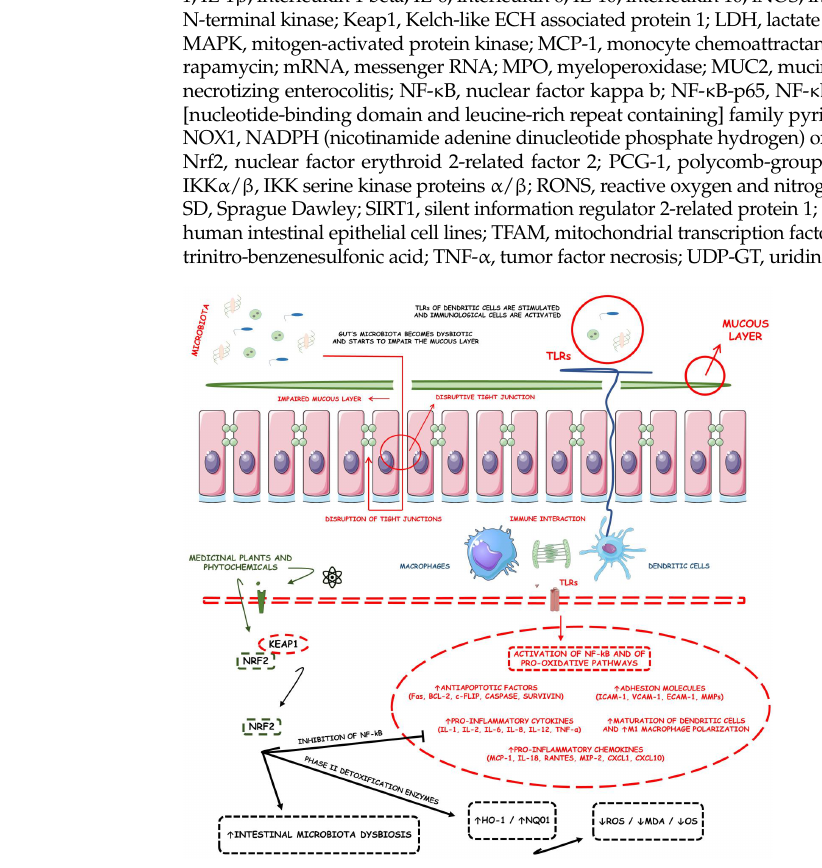
Figure 1. Inflammatory bowel diseases and regulation of Nrf2 using medicinal plants and phytochemicals. ↑ , increase; ↓ , decrease; Bcl-2, B-cell lymphoma 2; c-FLIP, cellular FLICE-inhibitory protein; CXCL1, chemokine (C-X-C motif) ligand 1; CXCL10, chemokine (C-X-C motif) ligand 10; ECAM-1, extracellular cell adhesion molecule 1; ICAM-1, intercellular adhesion molecule 1; IL-1, interleukin 1; IL-2, interleukin 2; IL-6, interleukin 6; IL-8, interleukin 8; IL-12, interleukin 12; IL-18, interleukin 18;